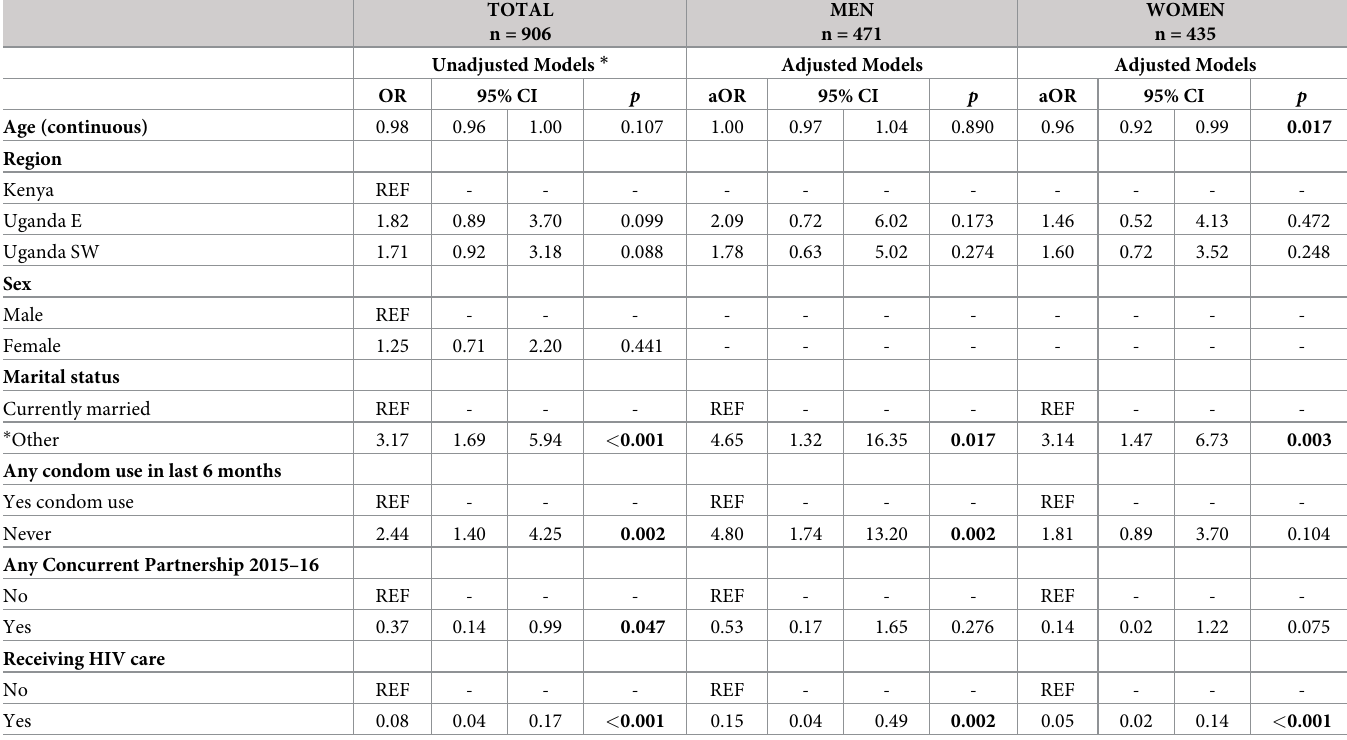
Table 4. Multivariate analysis examining factors associated with non-disclosure at basline, straified by sex and adjusted for community